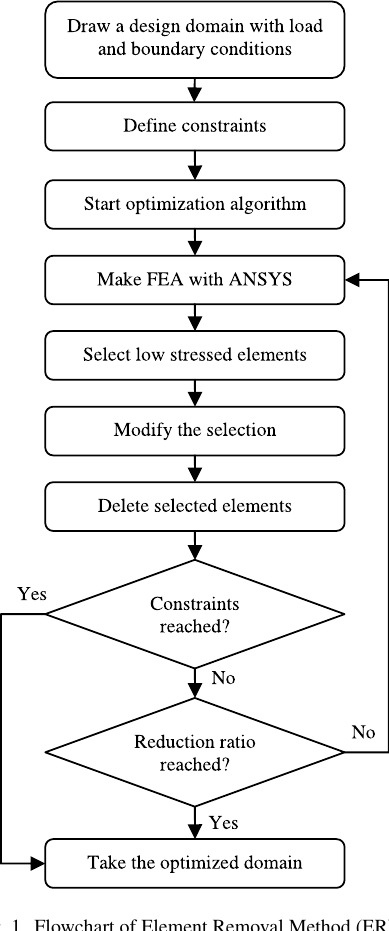
Fig. 1. Flowchart of Element Removal Method